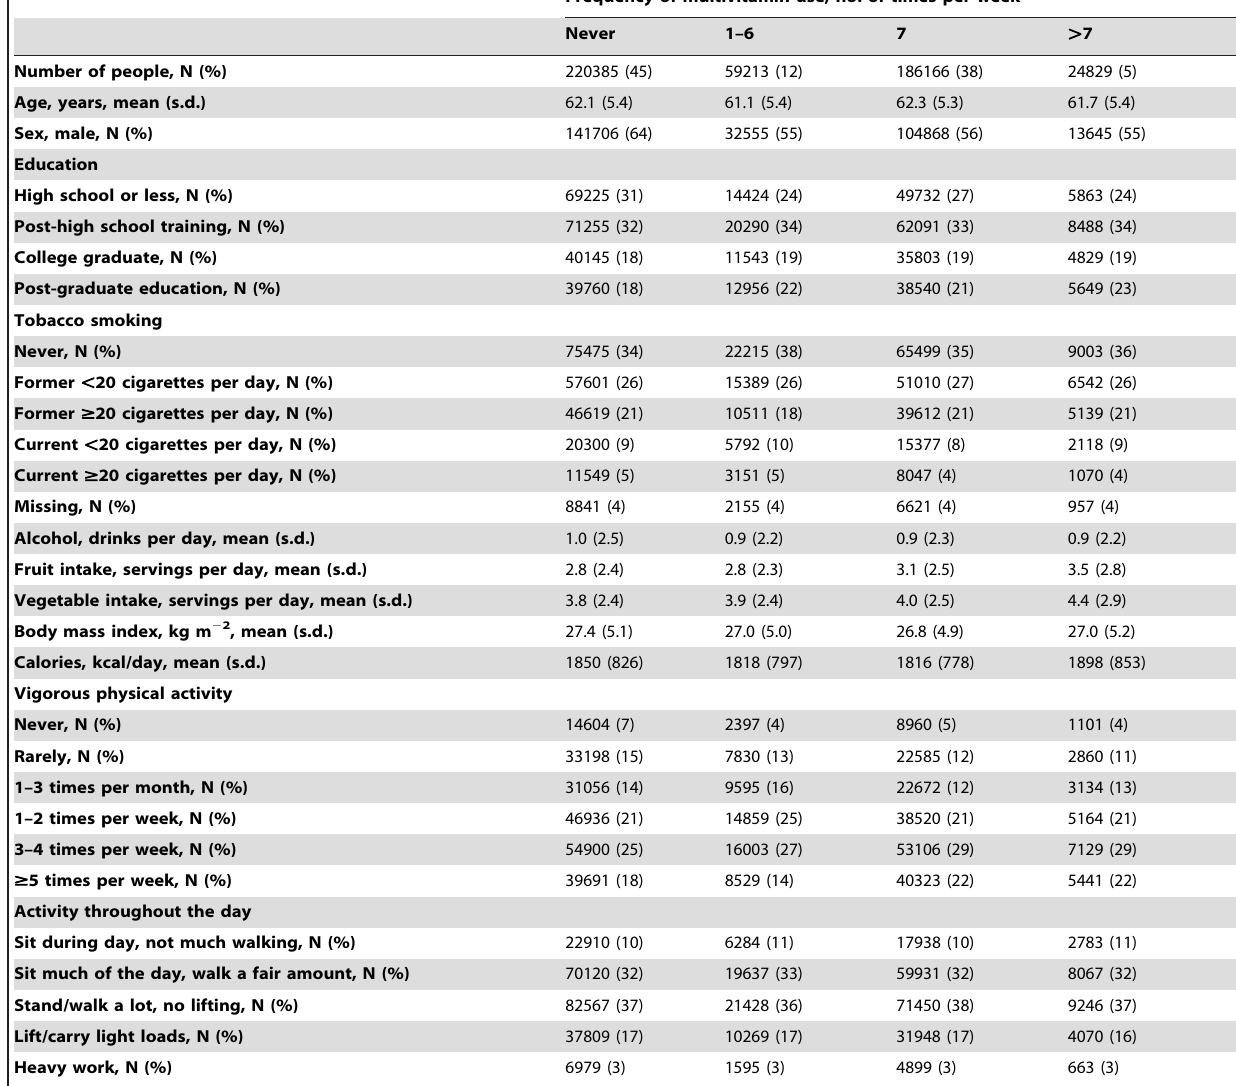
Frequency of multivitamin use, no. of times per